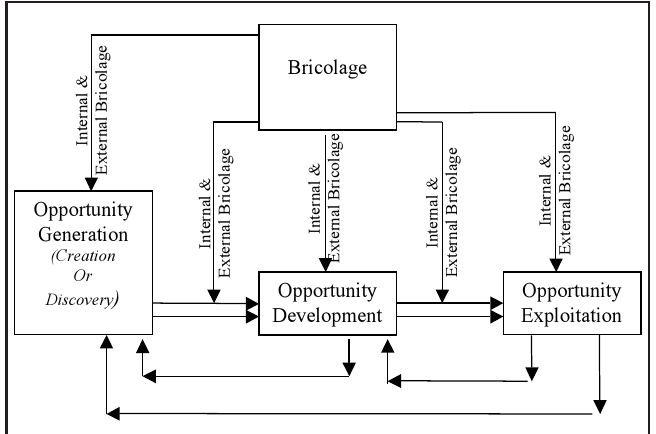
Figure 4. Conceptual Model for the Effect of